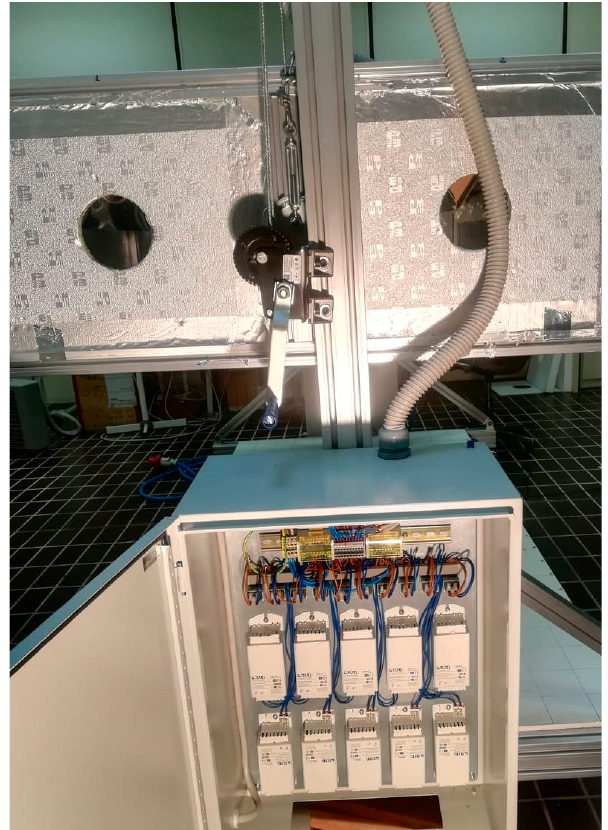
Figure 5. Detail of a side box.